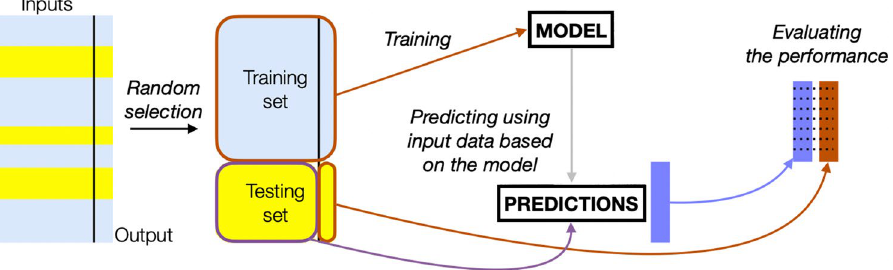
Figure 4. The schematic of the machine learning process after calculating input features inside areas of interest, where input features are automatically selected using the semantic segmentation